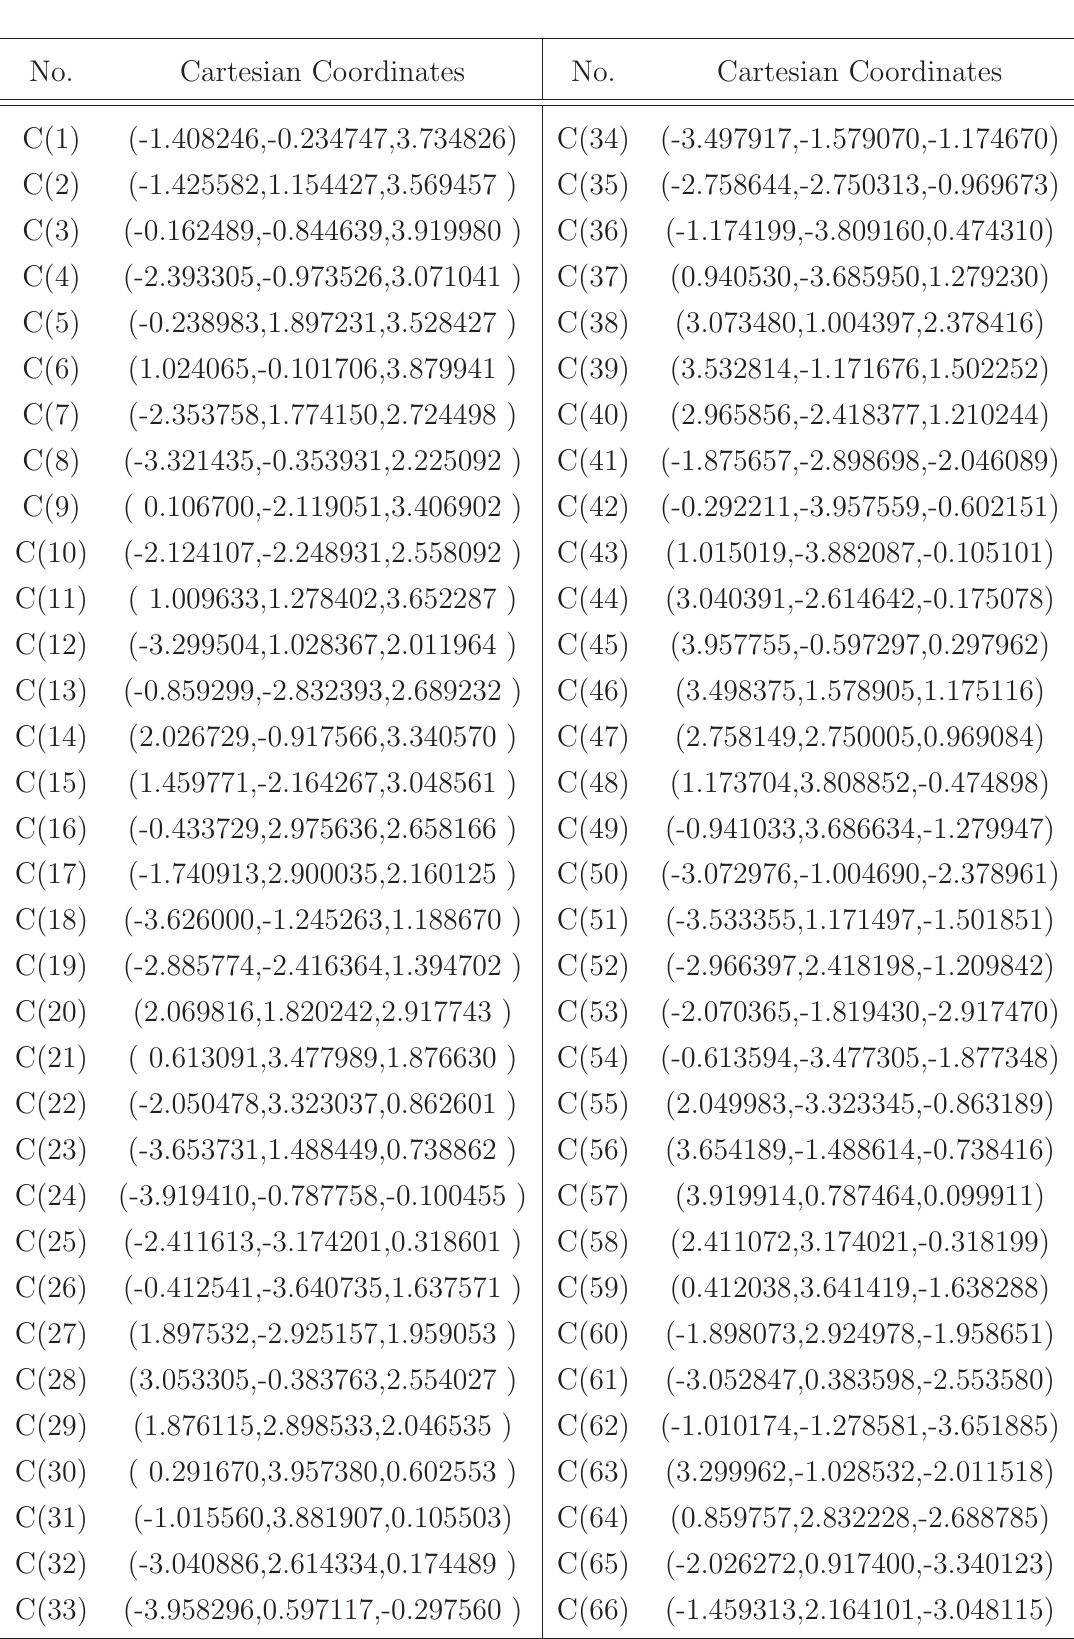
Table 1 Cartesian coordinates of C 80 molecule